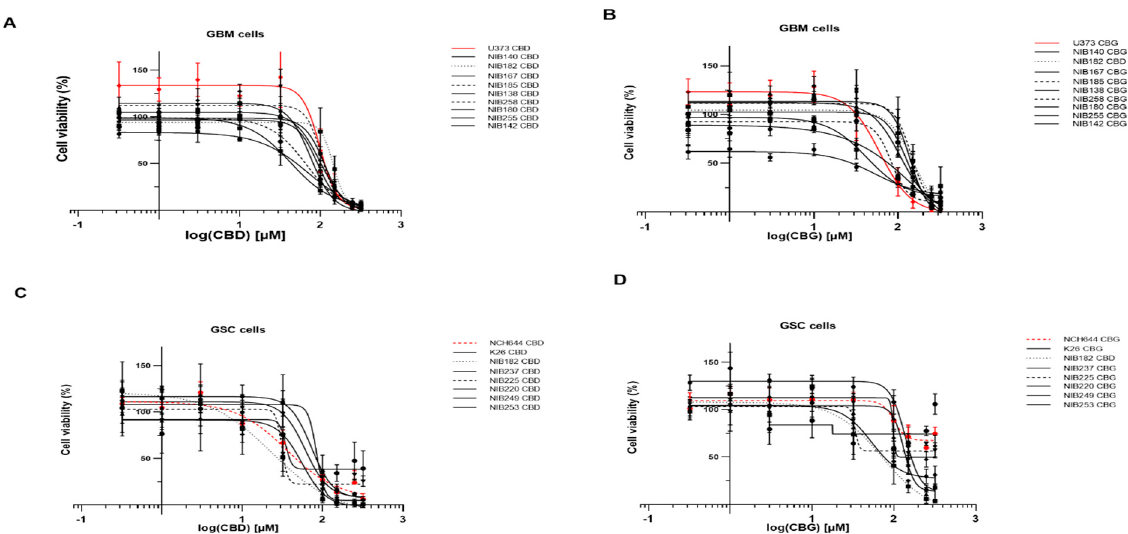
Figure 6. The cannabidiol (CBD) and cannabigerol (CBG) reduce viability of glioblastoma (GBM) and GBM stem cells (GSCs). CBD ( A , C ) and CBG ( B , D ) decreased the viability of ten differentiated GBM cells and eight GSCs. Dose responses of cell viability measured by MTT assay ( y -axis) and different CBD and CBG concentrations increasing in the range of 0.32–320 µ M ( x -axis log scale) on established GBM cells (U373 line) (A, B; red line) in comparison with patient-derived primary GBM cells (A, B; black lines). Established GSC lines NCH644k (C, D; red line) are compared with patient-derived primary GSCs (C, D; black lines) after 48 h of single treatment with cannabinoids. The solvents base emulsion or DMSO ( ≤ 0.4%, v / v ) were used as controls. Data are expressed as mean ± SE ( n = 3–5 independent biological experiments, each with technical triplicates). Vehicles comprised ≤ 0.1% base emulsion. Table 2. Mean IC50 (µM) values for glioblastoma (GBM) differentiated and GBM stem cells (GSCs) for cannabidiol (CBD) and cannabigerol (CBG) treatment alone and at the molar ratio of 3:1.